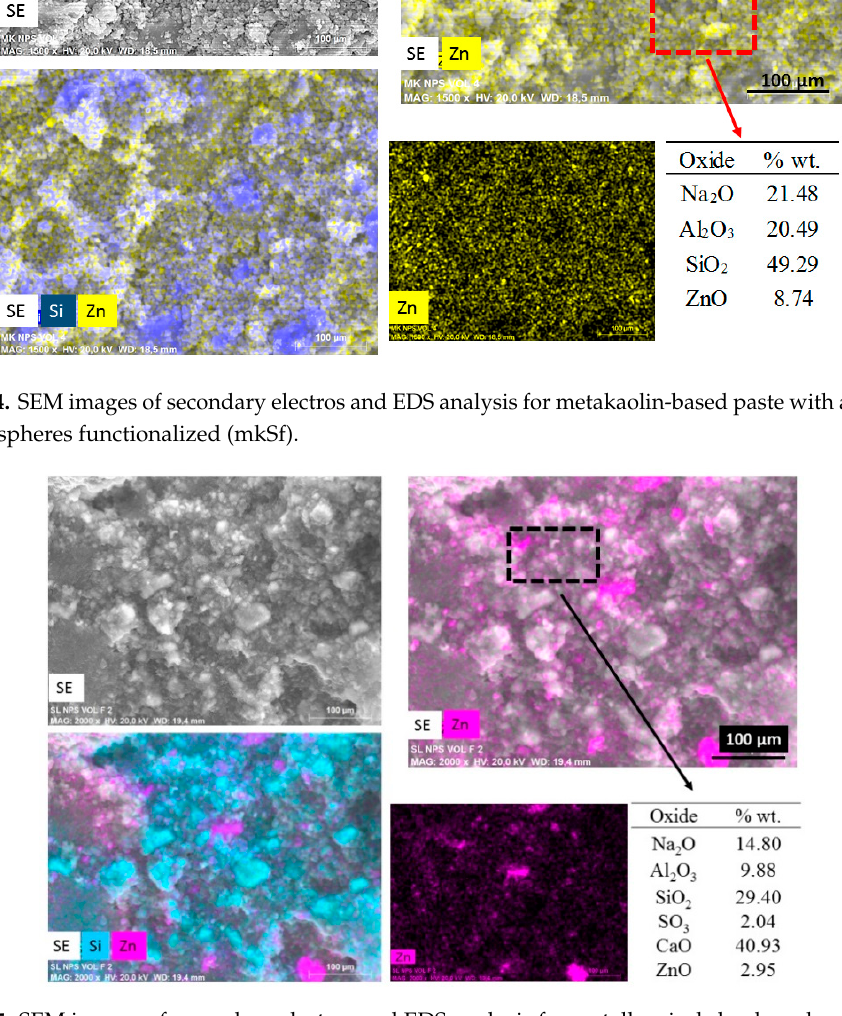
Figure 5. SEM images of secondary electros and EDS analysis for metallurgical slag-based paste with addition of nanospheres functionalized (slSf paste).